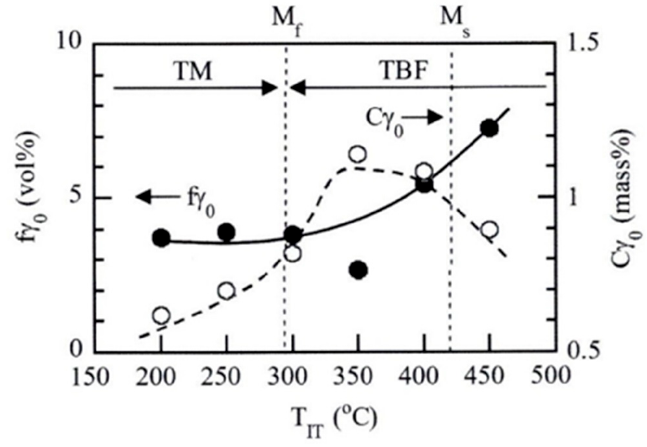
Figure 4. Variations in initial volume fraction (f γ 0 , ● ) and carbon concentration ( C γ 0 , ○ ) of retained austenite as a function of isothermal transformation temperature ( T IT ) in 0.20C-1.59Si-1.50Mn-0.05Nb (mass%) TBF and TM steels [51]. The holding time of the IT process is 1000 s. This figure is reproduced based on reference [51].